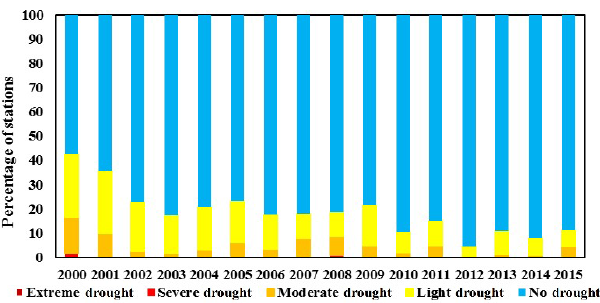
Figure 7. Frequency of occurrence of drought in six categories in the Wei River Basin during the period of 2000–2015.